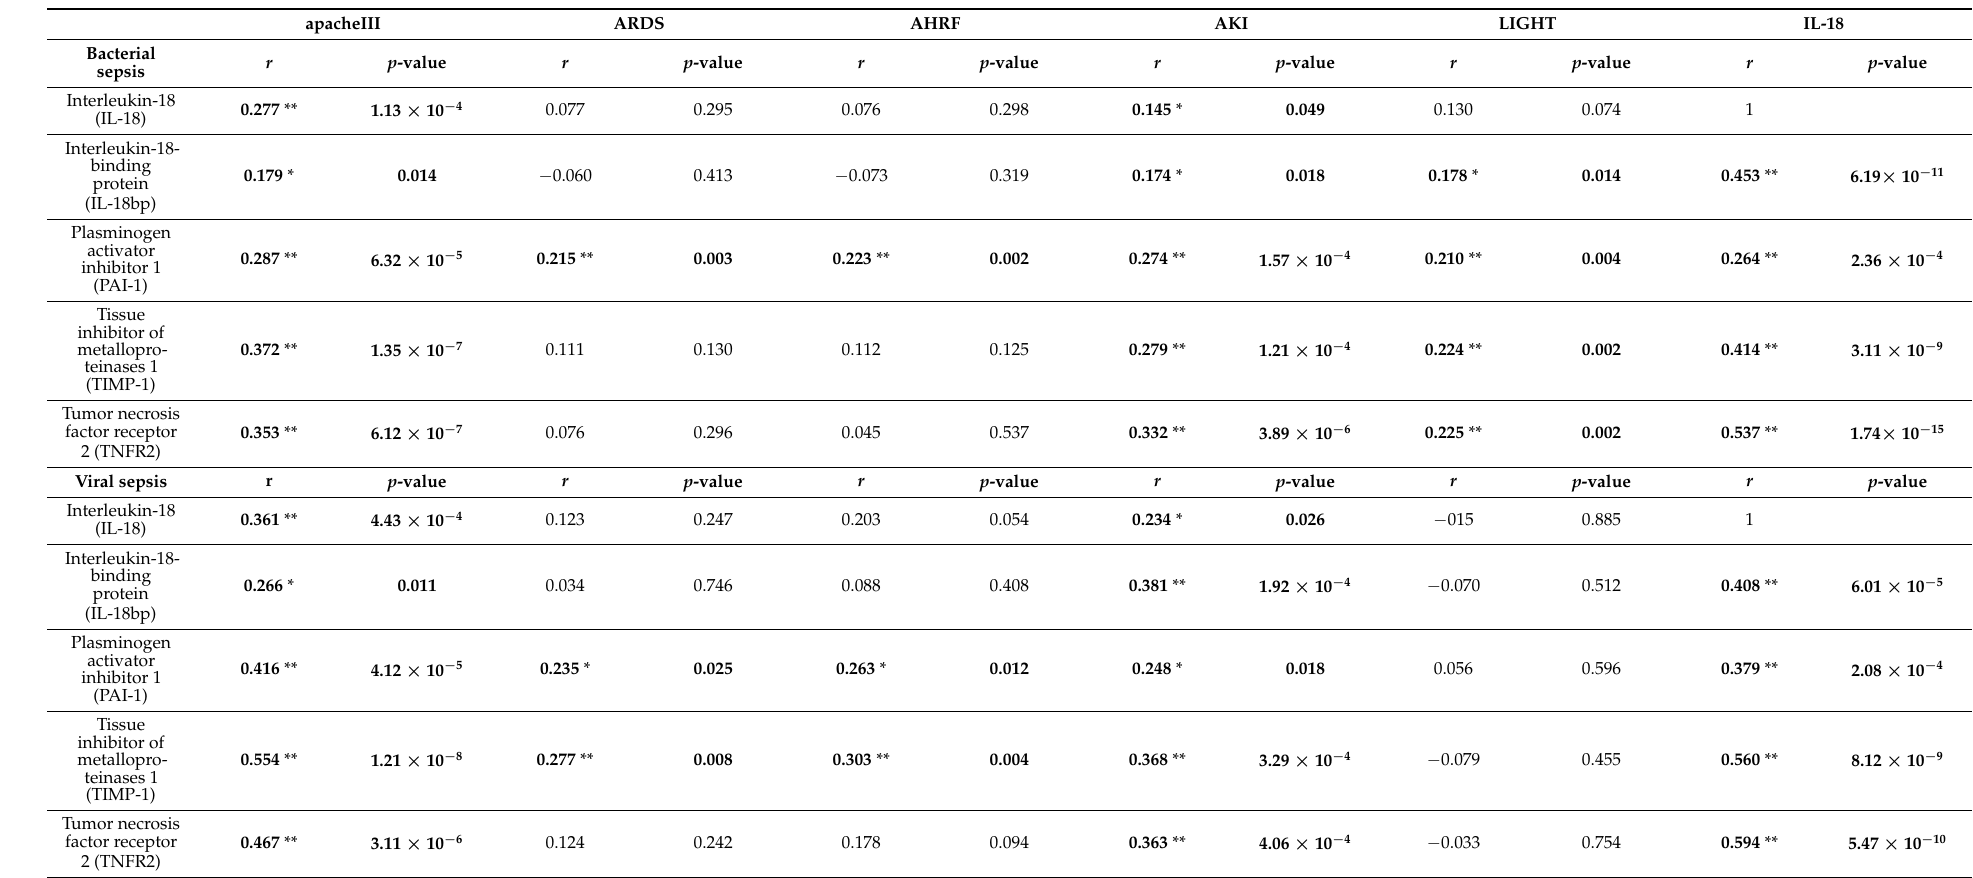
Table 4. Correlation of elevated LIGHT and Ln (IL-18) with biomarkers of organ